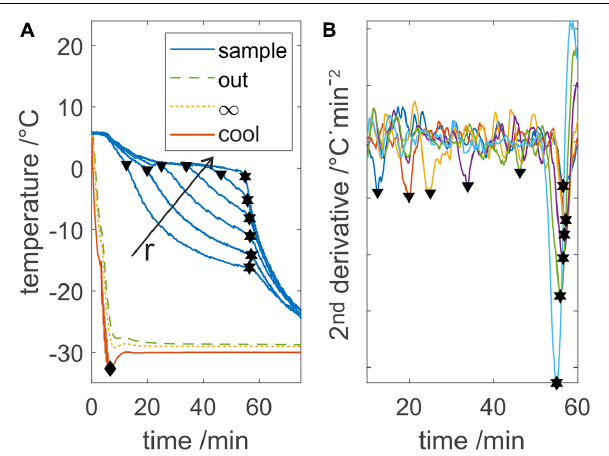
FIGURE 2 | Process temperatures evaluation example. (A) Displays the measured device temperatures T out , T ∞ , and T cool and five out of 13 sample temperatures. The diamond shape indicates the cooldown time, triangle shows the freezing at an individual probe, and hexagons show the LPTF. Freezing at individual probes and the LPTF time are calculated based on minima in the second derivative of the sample data, which is shown in panel (B) . r indicates the increasing distance of the temperature probe from the cooling surface. Individual sample temperature profiles are colorized in panel (B) for